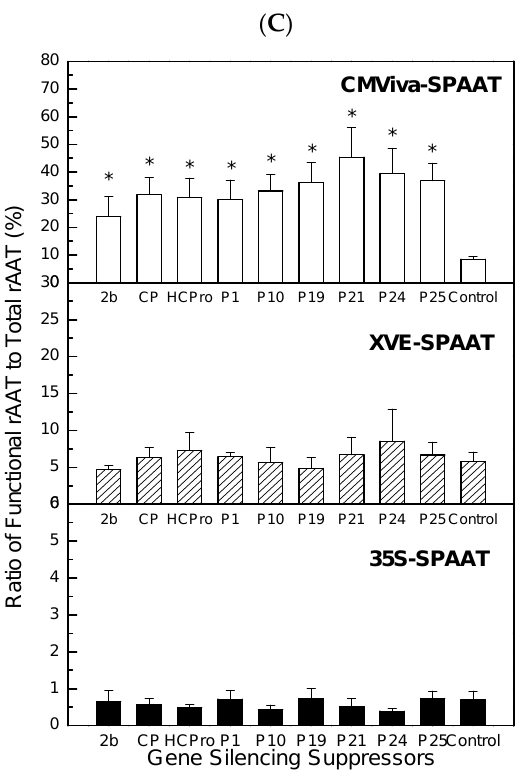
Figure 8. Effect of viral gene silencing suppressors on extracellular total rAAT production ( A ), extracellular functional rAAT production ( B ), and ratio of functional rAAT to total rAAT ( C ) in transgenic plant cell cultures (CMViva, XVE or 35S). Error bars represent one standard deviation of measurements obtained from triplicate sample assays of duplicate experiments. Asterisks on the graphs indicate a statistically significant difference from the control ( p ≤ 0.05).